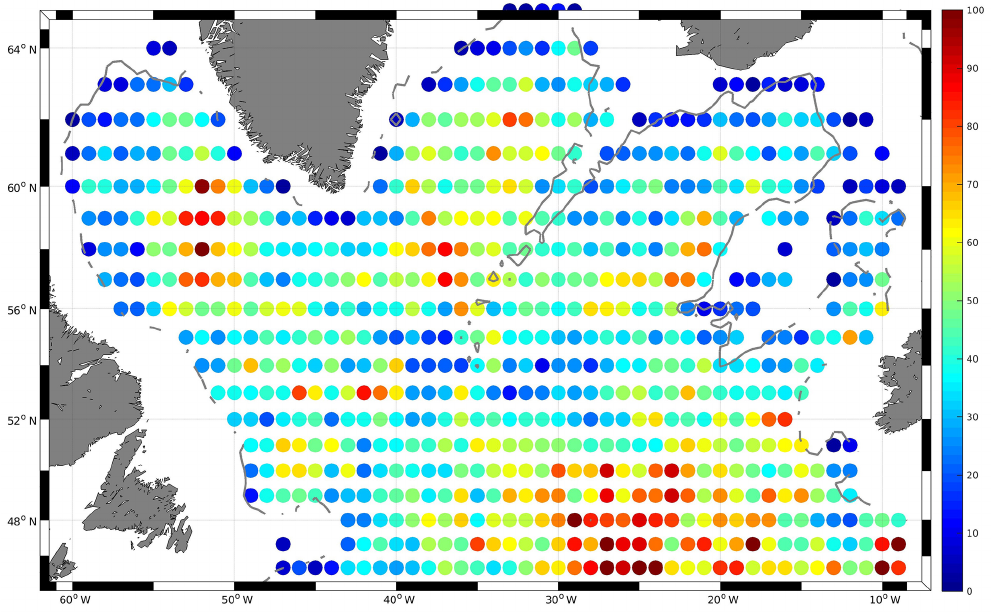
Figure 1. Data density in 1 ◦ × 1 ◦ fields; the number of 10-day displacement vectors per